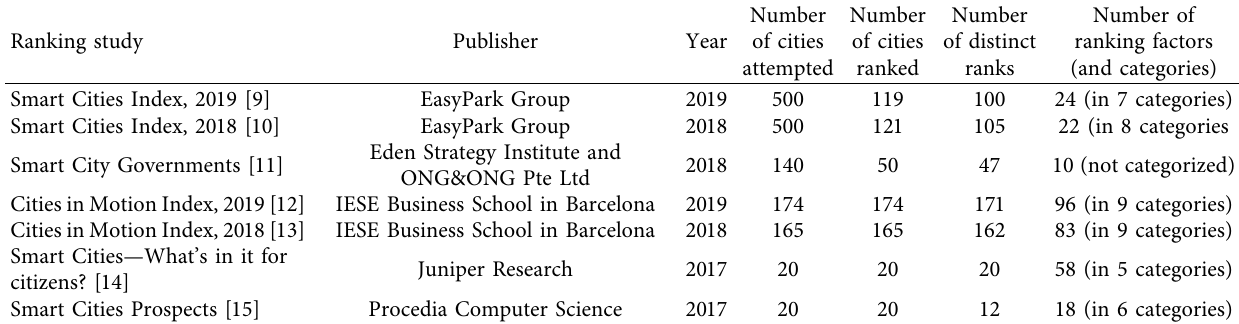
Table 1: Key features of the 7 ranking studies